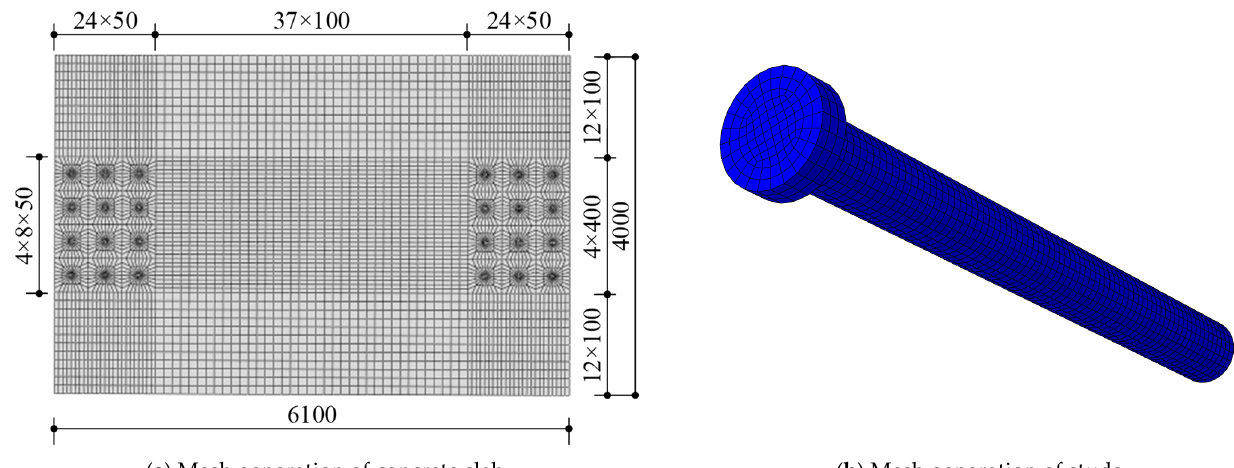
Figure 3. Elaborate FEM of the steel ‒ concrete composite beam.